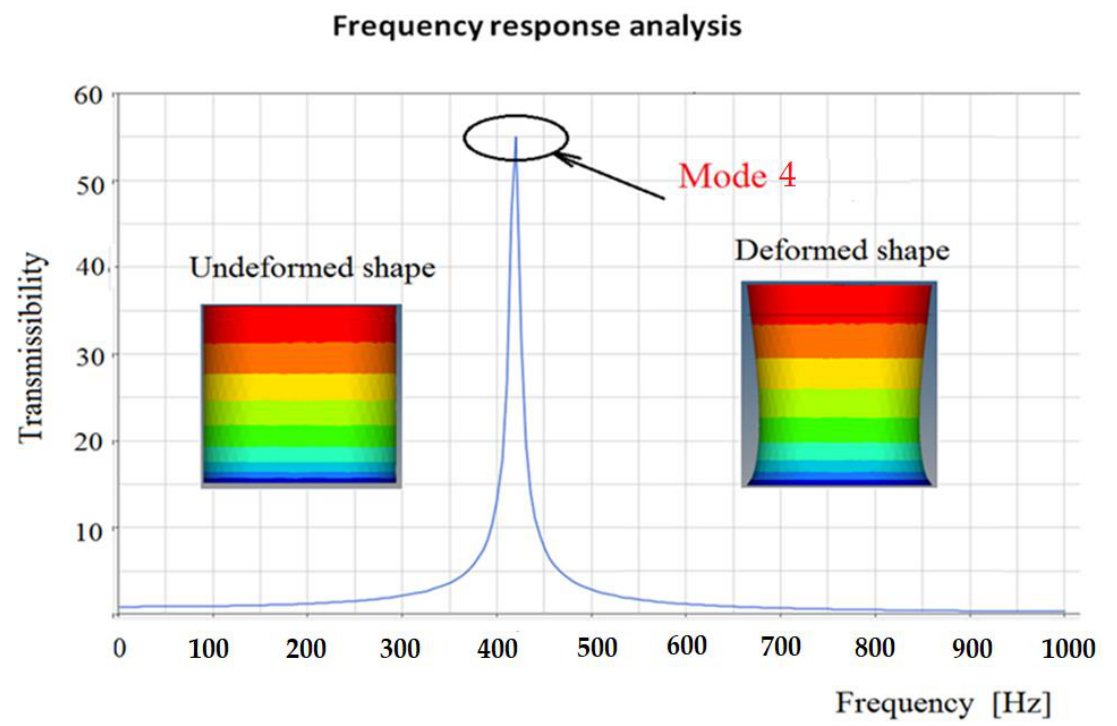
Figure 7. Frequency response for a rubber model, with a structural damping of 2%.